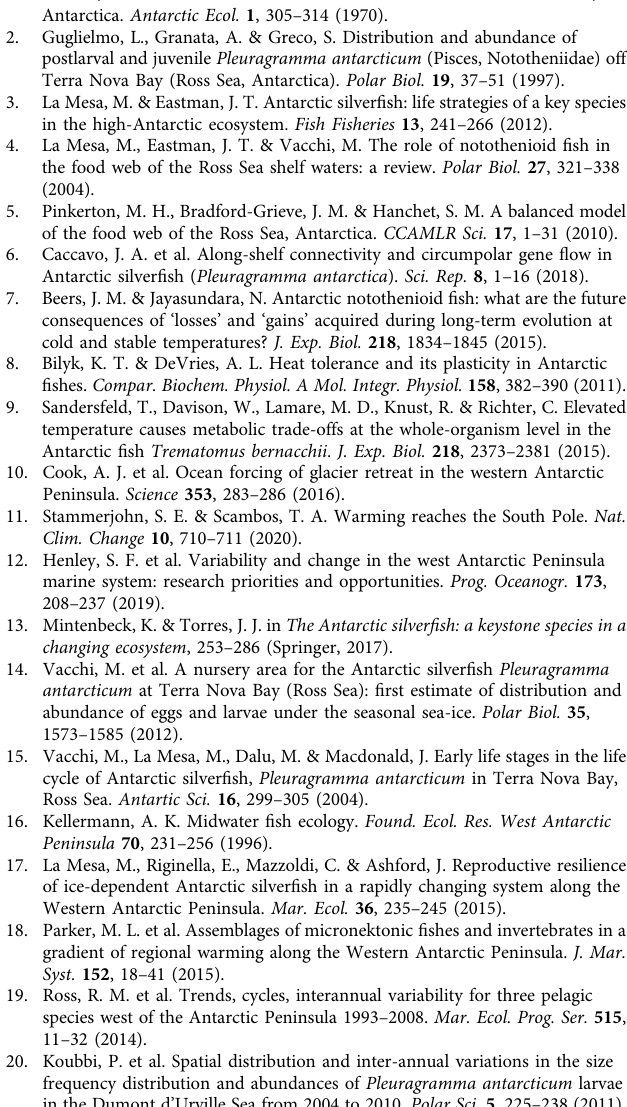
Figure development . Figure 1. Monthly sea ice concentration anomalies are derived from the SMMR/SSM/I satellite time series based on the Goddard Space Flight Center (GSFC) Bootstrap algorithm 115,116 . The sea ice concentration data are gridded to 25 km and are provided by the EOS Distributed Active Archive Center (DAAC) at the National Snow and Ice Data Center (NSIDC, University of Colorado at Boulder, http://nsidc.org). The numerically analyzed monthly 10-m height winds and sea-level pressure anomalies are from the fi fth-generation Eur- opean Centre for Medium Range Weather Forecasts (ECMWF) Reanalysis (ERA- 5) 117 and are provided by the Climate Data Store (CDS, https:// cds.climate.copernicus.eu/).